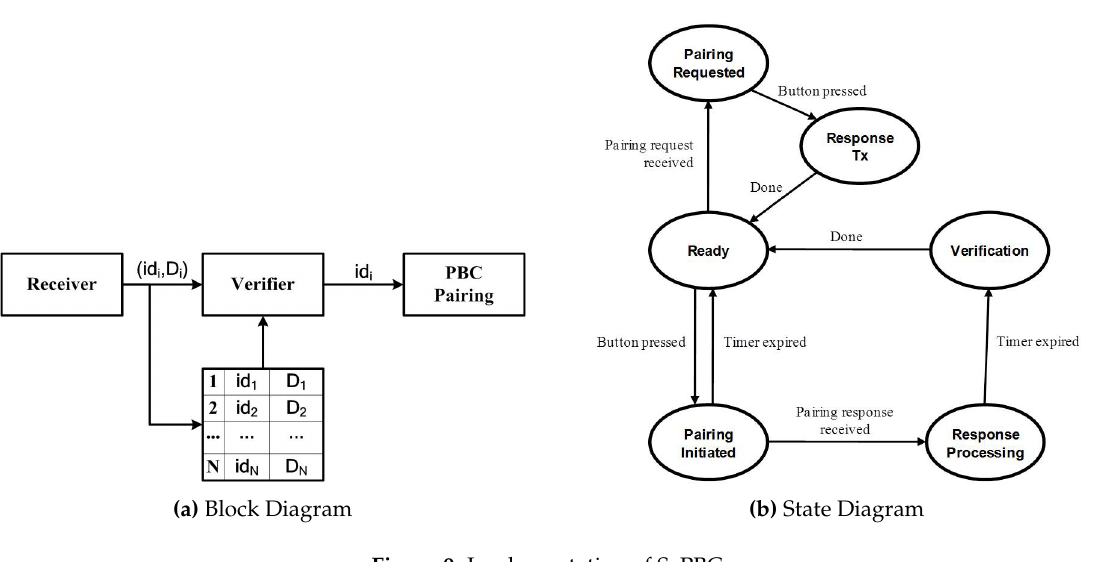
Figure 9. Implementation of